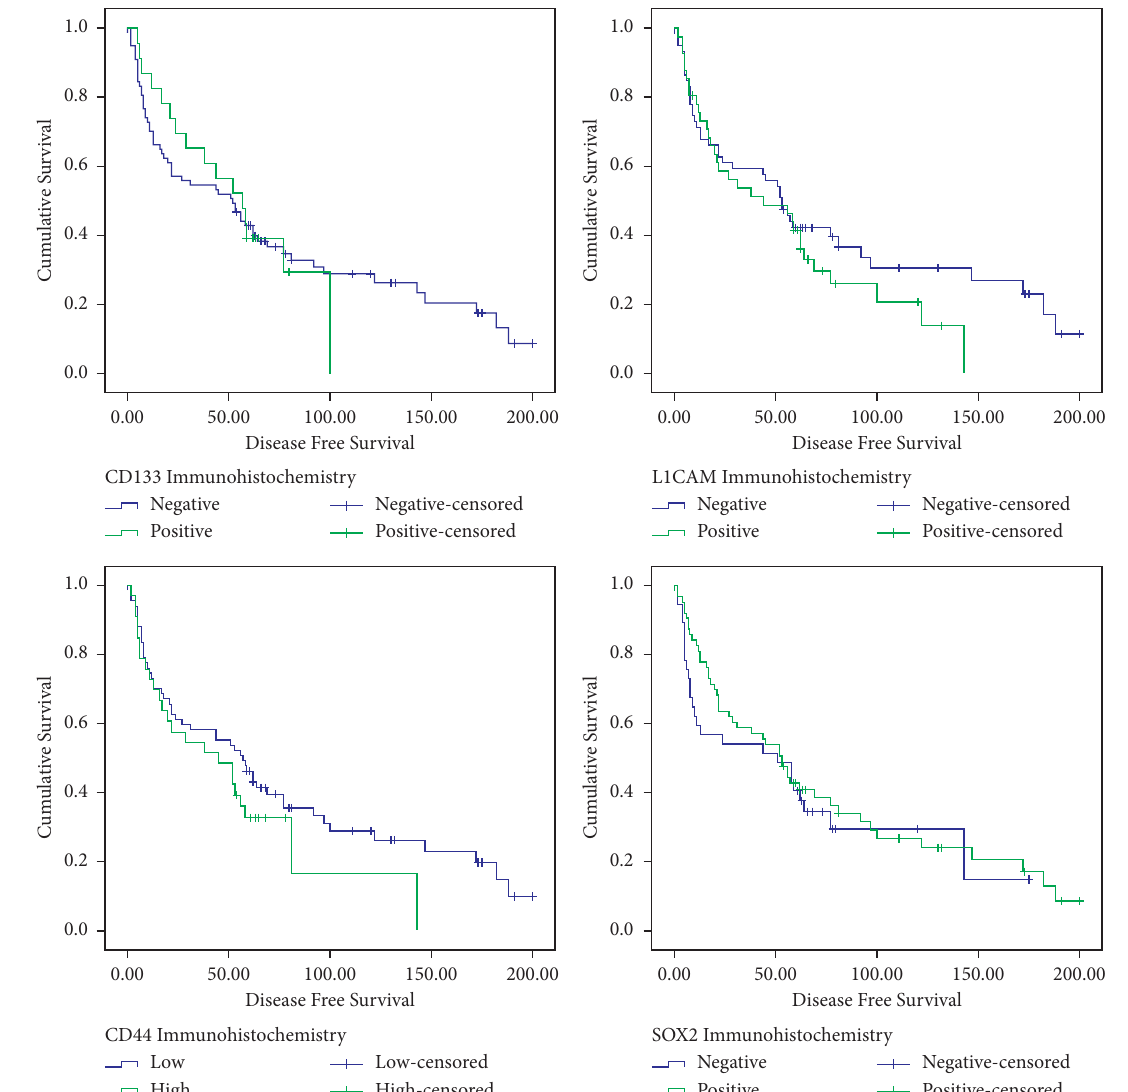
Figure 3: Kaplan–Meier curve analysis for disease-free survival of OSCC patients with P � 0 . 996 for CD133 expression, P � 0 . 24 for CD44 expression, P � 0 . 266 for L1CAM expression, and P � 0 . 483 for SOX2